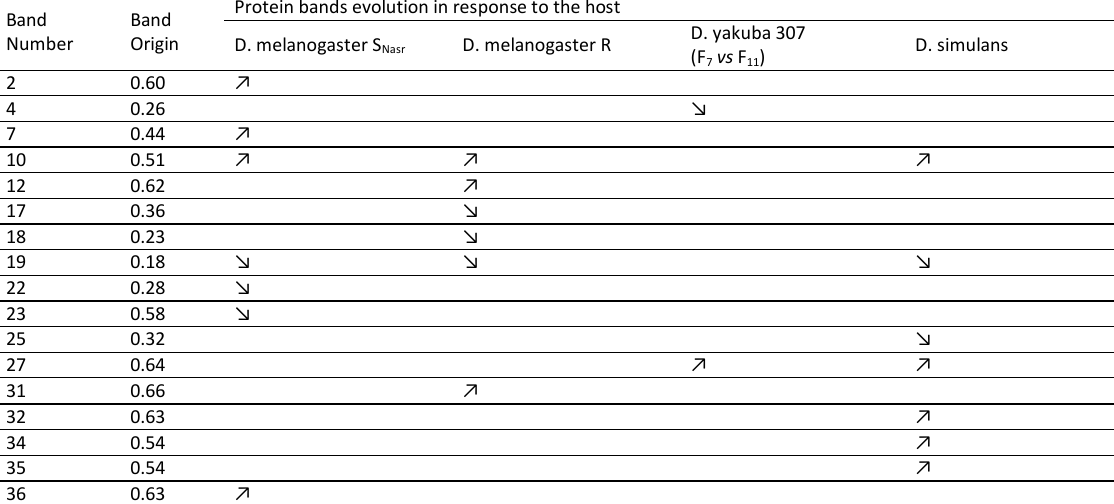
discriminant axes 1 and 2 (A) and discriminant axes 3 and 4 (B). C-H. Discriminant analysis performed on the two first discriminant axes for each two-by-two comparison of venom composition between parasitoids selected on different hosts. For each of these LDAs, the pair of host considered is indicated at the left. Individuals are grouped and coloured according to their selection host and generation. The dotted arrows representing the direction of the venom evolution are the linear regressions fitted to the coordinates of the three centroid points (F 3 , F 7 and F 11 ). P-values obtained from the PERMANOVA for effects of the “generation”, “host” and “generation × host” interaction are provided at the bottom right of the LDA (see Table S5 for more details). Table 1 . Summary of protein bands evolution in response to the host. Only protein bands correlated to regressions (arrows) in Figure 3 and S5 in response to at least one host are represented. A up arroow ( ↗ ) corresponds to a selection, a down arrow ( ↘ ) to a counter-selection in response to the host. The origin of the band was estimated by dividing the band intensity in ISm venom by the sum of its intensity in ISm and ISy venoms; 0 < ISy <0.5; 0.5 < ISm < 1. For the complete data, see Table